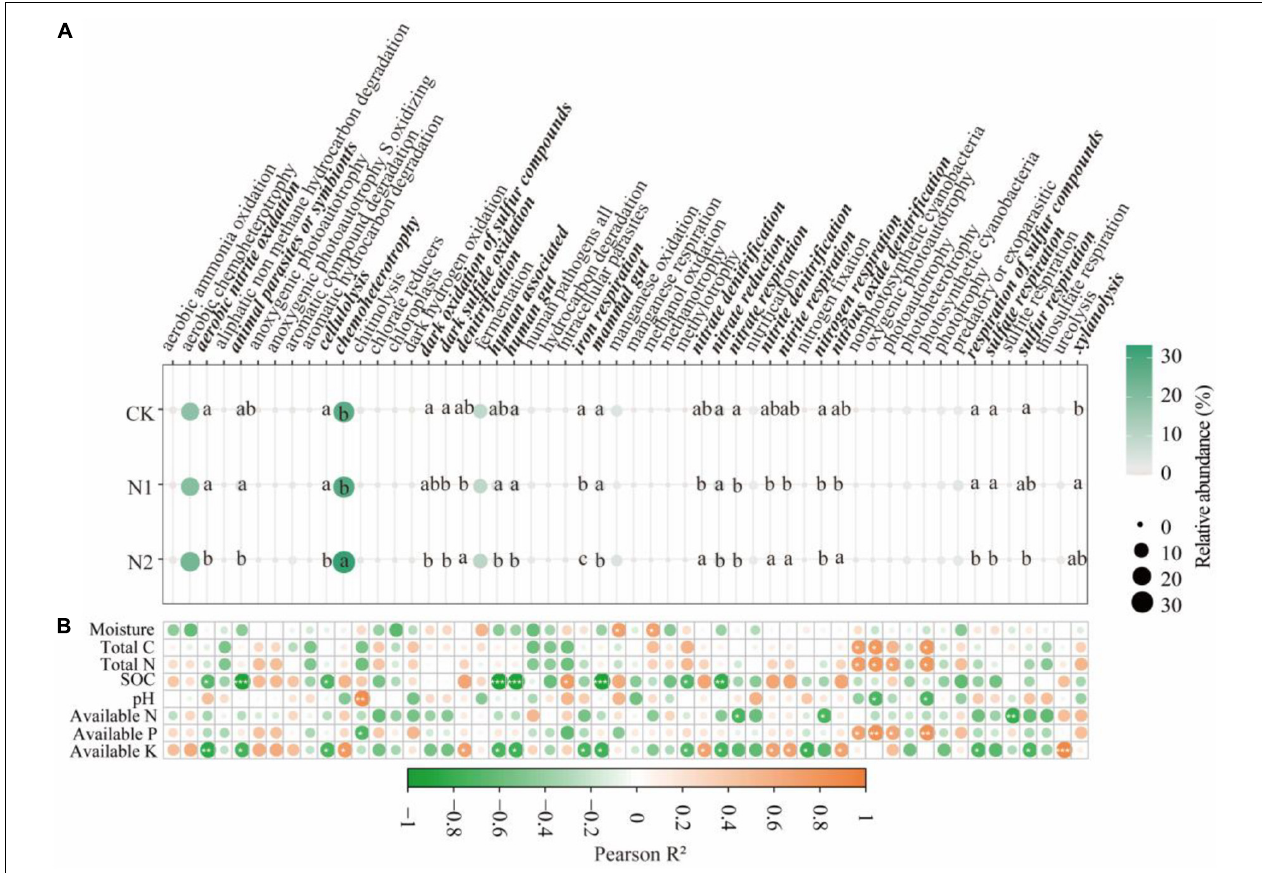
FIGURE 5 | Prediction of soil bacterial function after N application and its correlation with soil factors. (A) Prediction of soil bacterial function. The same lowercase letter indicates no significant difference, but the difference is significant at the 0.05 level. (B) Correlation between bacterial function and soil factors. * P < 0.05, ** P < 0.01, *** P < 0.001. Bacteria function with significant differences are highlighted in bold